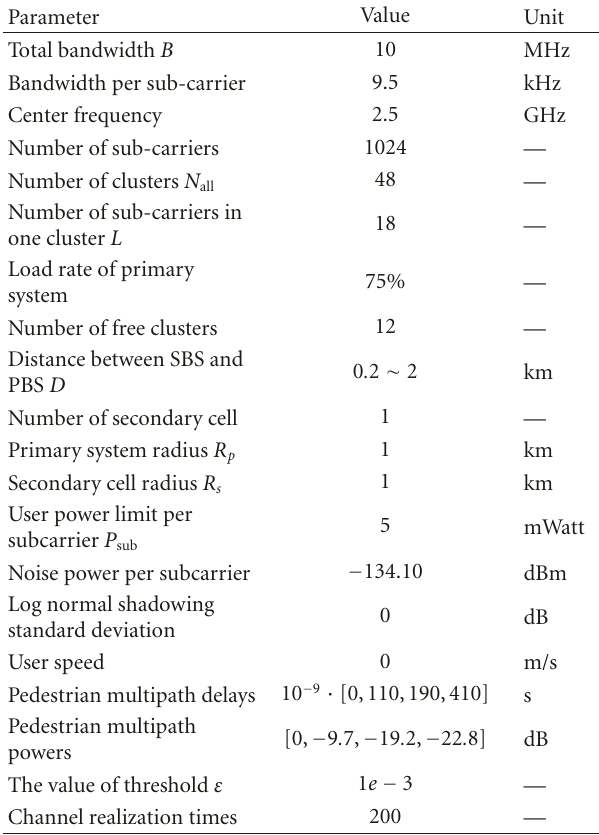
Table 4: System simulation